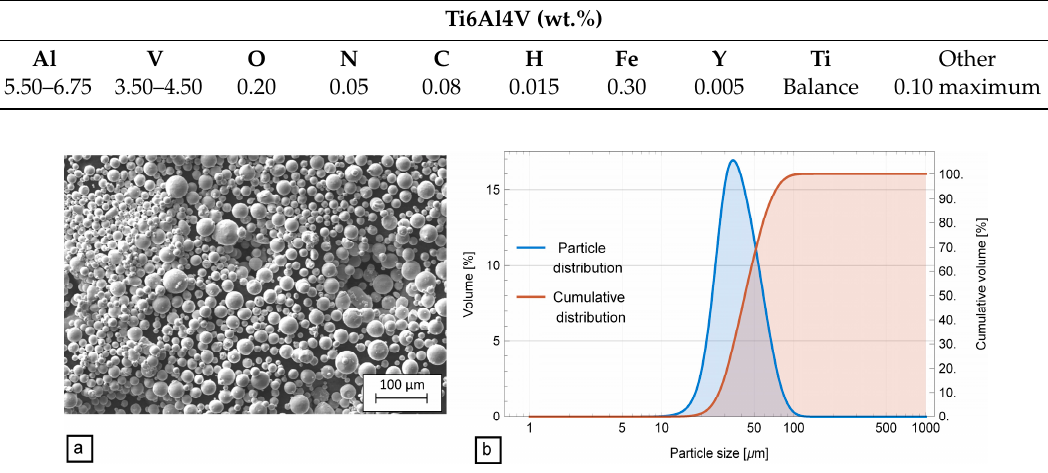
Figure 1. SEM image of Ti6Al4V powders ( a ); granulometry distribution ( b ). Table 1. Chemical composition of Ti64Al4V.